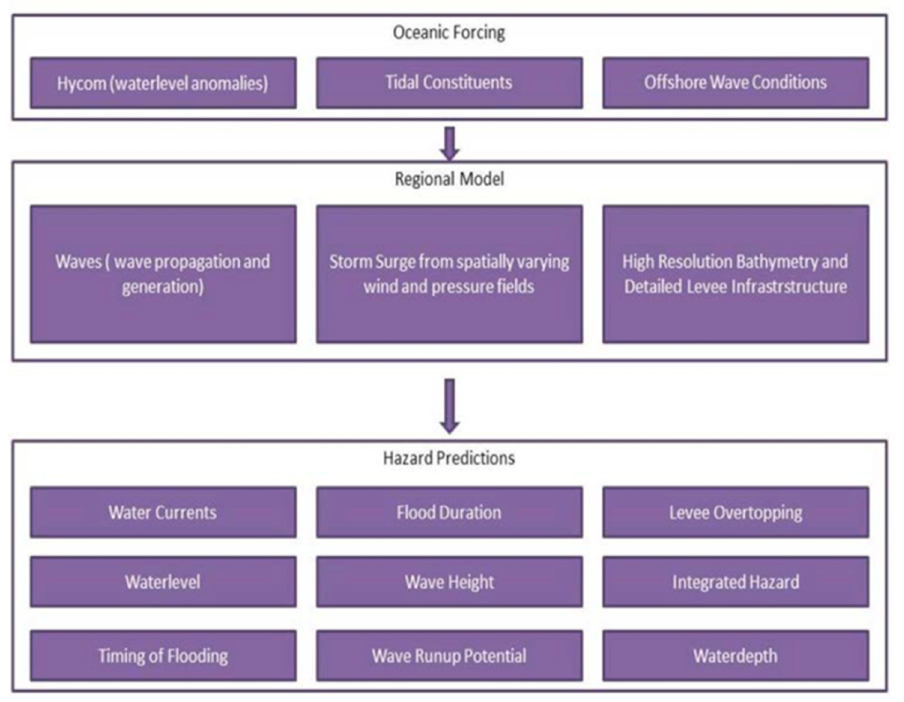
Figure 4. CoSMoS components.